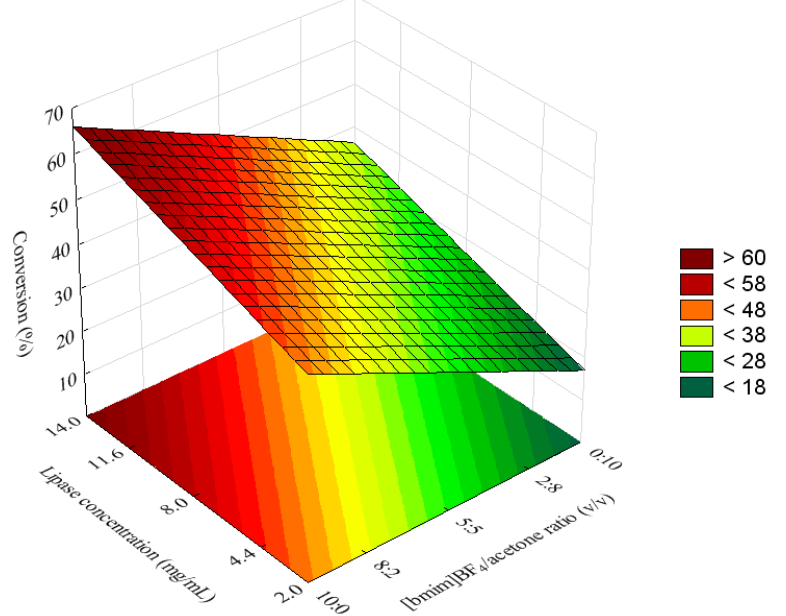
Figure 4. Response surface for esterification of hesperidin with decanoic acid catalyzed by immobilized CALB at 50 °C for 96 h, as a function of the molar ratio of [bmim]BF and lipase concentration, hesperidin to decanoic acid and lipase concentration. The molar ratio of hesperidin to decanoic acid was fixed as